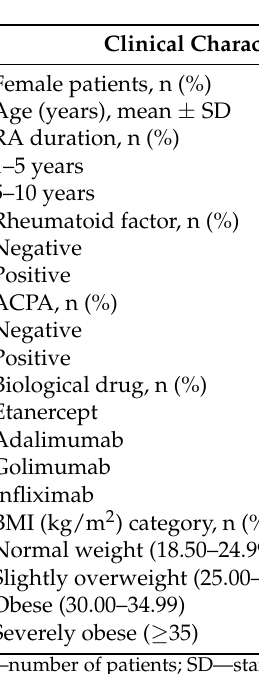
Table 1. Baseline clinical characteristics of rheumatoid arthritis